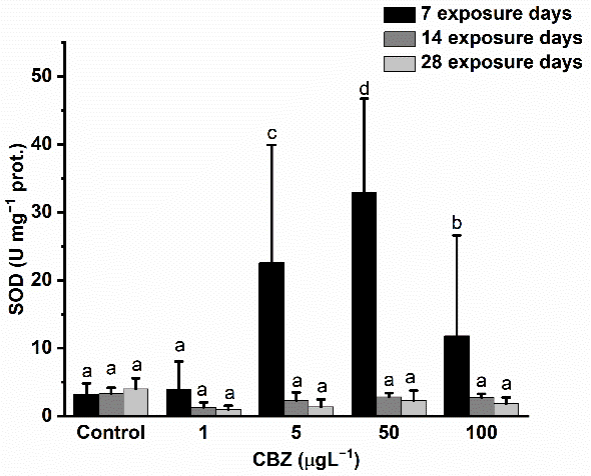
Figure 5. Changes in the SOD activity in the liver of Cyprinus carpio exposed to CBZ for 7, 14, and 28 d. Data are expressed as mean ± standard deviation of three replicates ( n = 3). Different letters designate significant differences at p < 0.05 after a two ‐ way ANOVA followed by Tukey’s post ‐ hoc test. VTG levels increased following a concentration-dependent pattern after the first seven days of exposure. A significant ( p < 0.05) elevation of VTG content in the samples was detected in fish subjected to 50 and 100 µ g/L CBZ exposure. After 14 days, VTG levels returned to a level similar to the control groups, but no significant differences were observable. After the 28th exposure day, no significant ( p < 0.05) elevation in VTG levels was detected compared to the control groups (Figure 6).